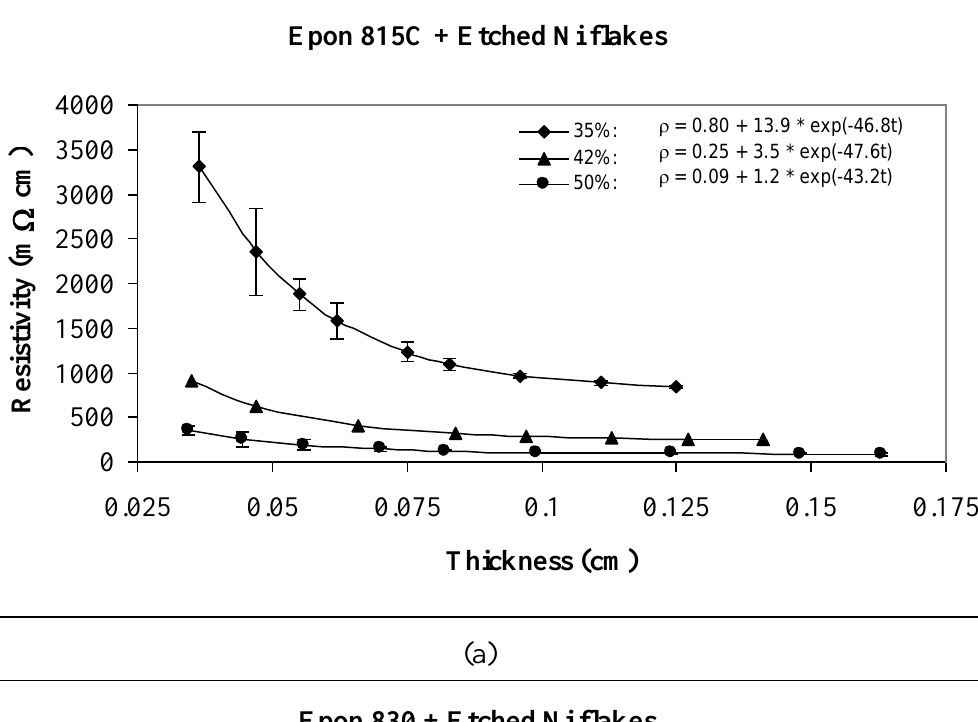
Figure 4. Thickness-dependent resistivity of Epon 815C ( a ), and 830 ( b ) films filled 35%, 42% and 50% by volume with etched nickel